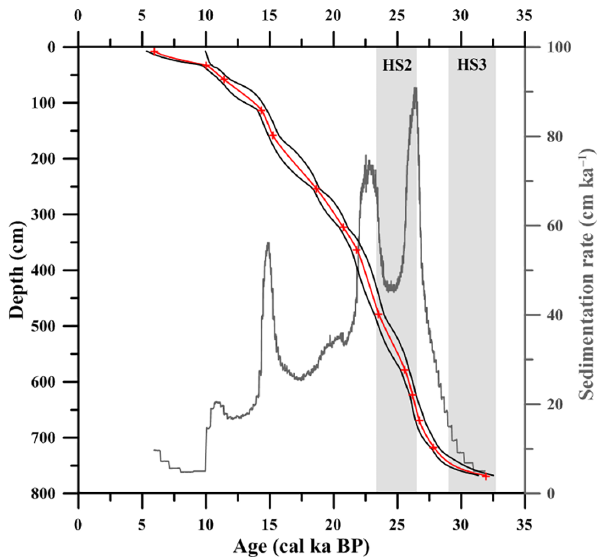
Figure 3. Age model (left-hand side y axis; red line and black en- veloping curves) and sedimentation rates (right-hand side y axis; grey line) for marine sediment core GeoB6212-1 produced with the software Bacon 2.2 (Blaauw and Christen, 2011). For the age model, the red symbols show calibrated ages, the red line depicts mean ages, and the upper (lower) black line depicts maximum (min- imum) ages. Grey vertical bars show abrupt millennial-scale